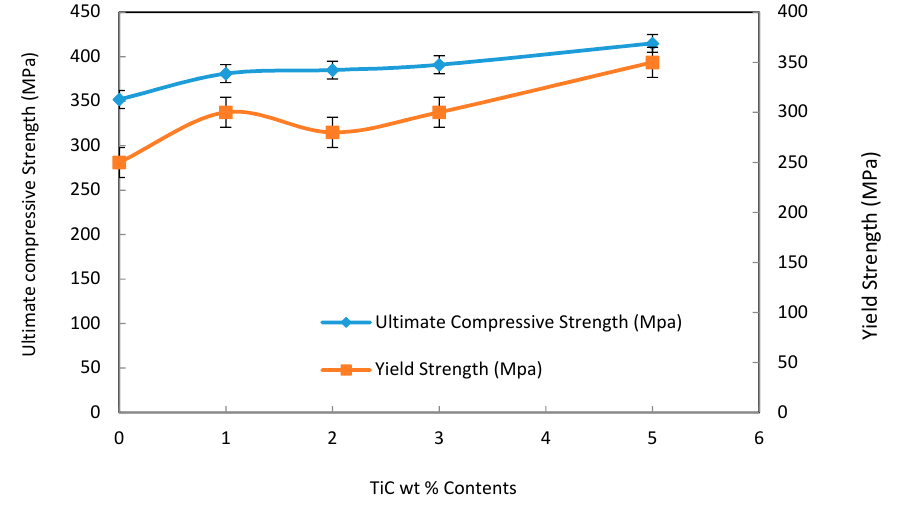
Figure 14. The dependence of yield and compressive strength of Al on the TiC nanofiber contents.